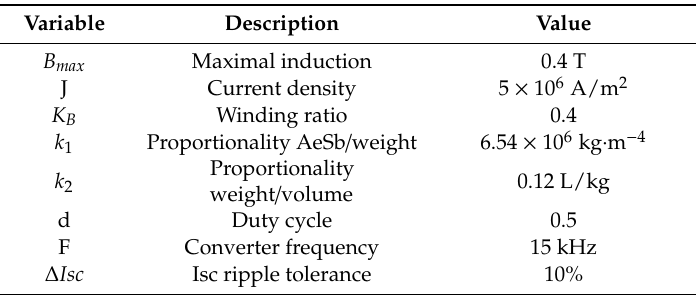
Table 2. Converter data.